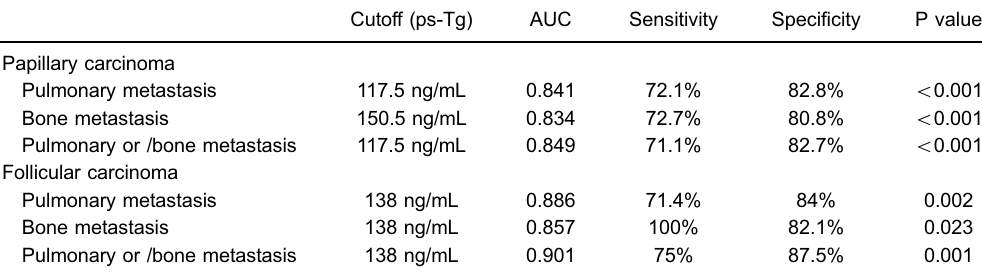
Table 6. Ps-Tg values to identify distant metastasis in patients with papillary and follicular thyroid